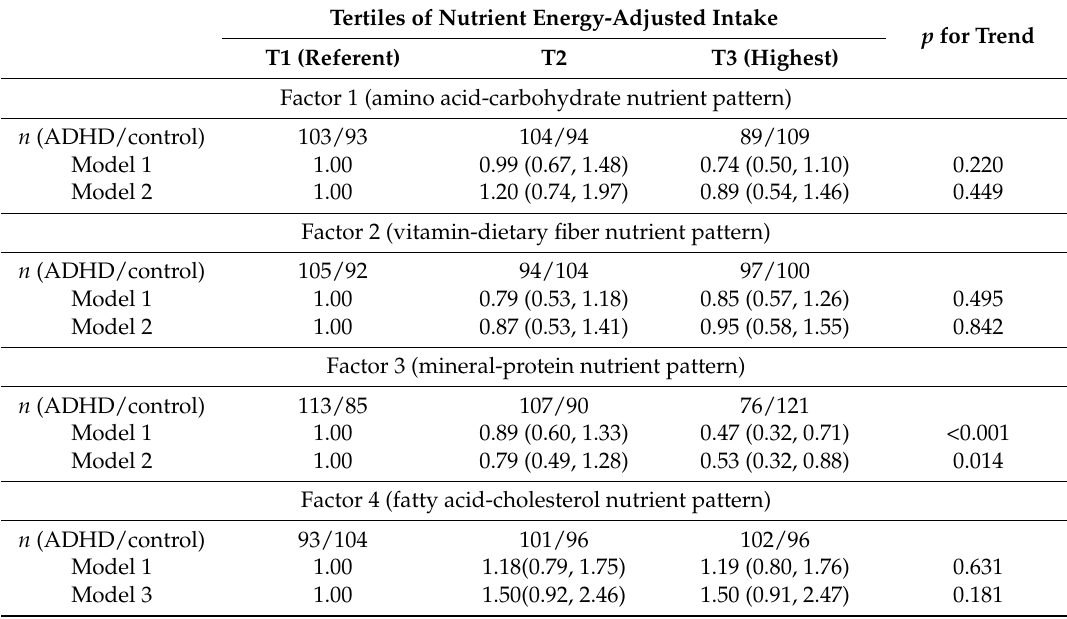
Table 5. Odds ratio (95% CIs) of ADHD for tertiles of nutrient patterns 1 . Tertiles of Nutrient Energy-Adjusted Intake